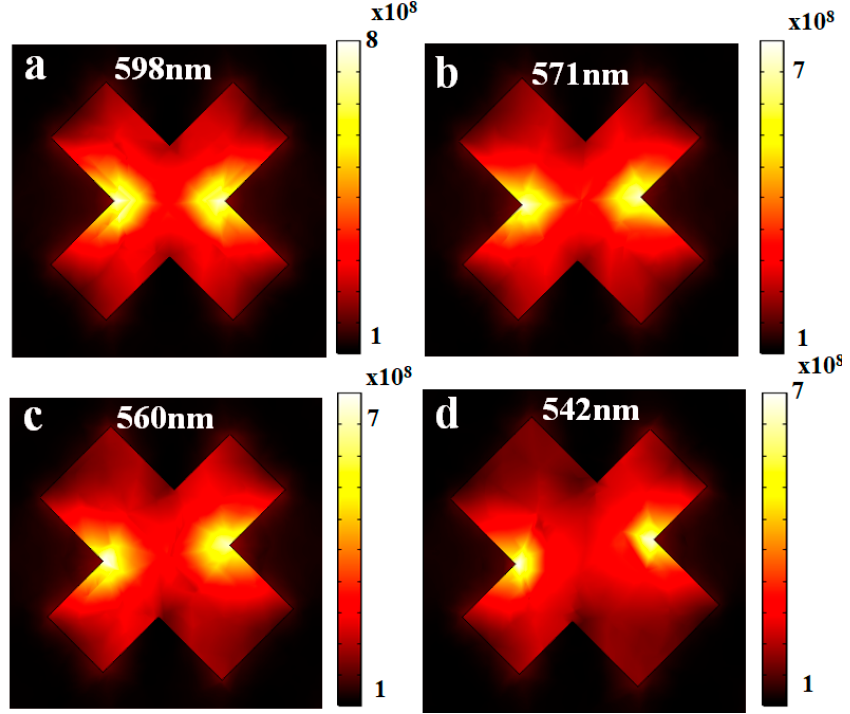
Figure 12. Electric field distribution at wavelengths 598 nm ( a ), 571 nm ( b ), 560 nm ( c ), and 542 nm ( d ) for defective structure for d4.